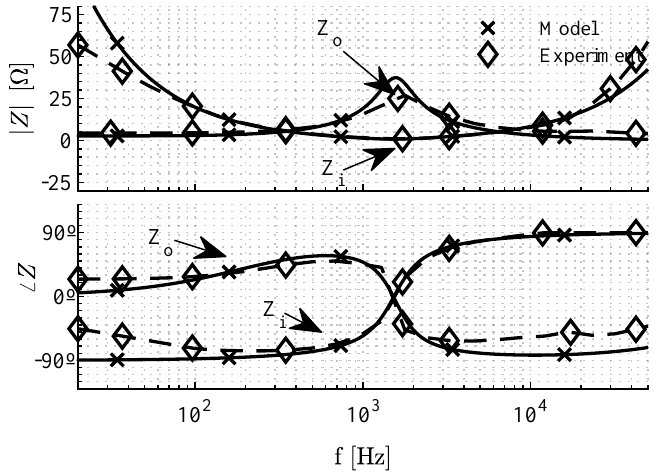
Figure 13. Bode plot for the open-loop input and open-loop output impedances at D = D’ = 0.5.